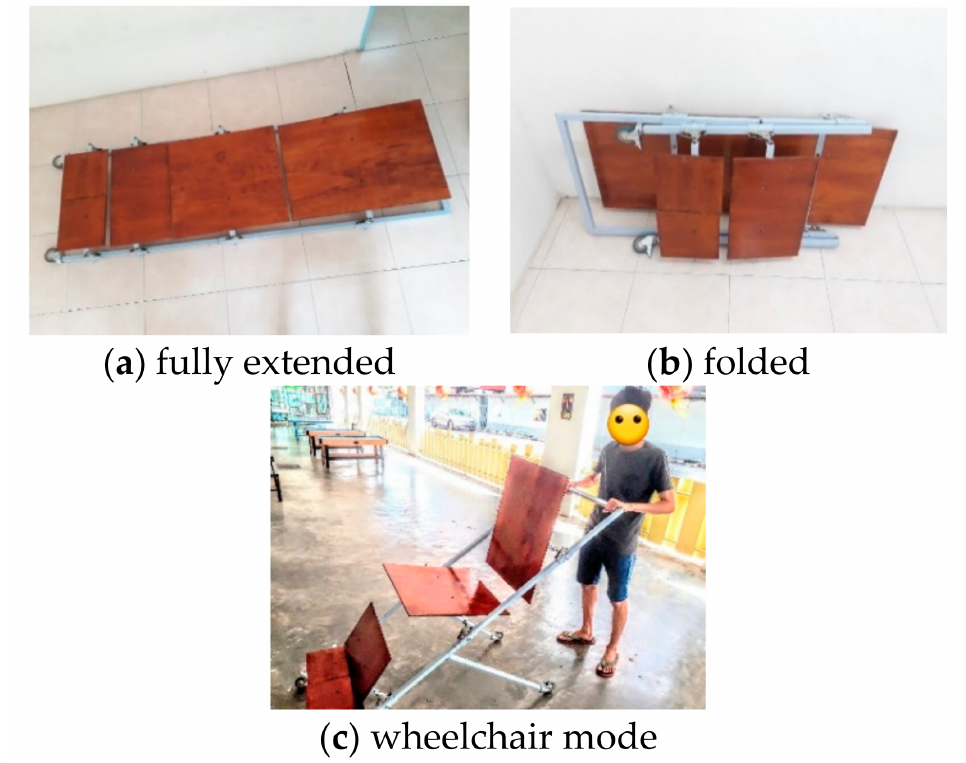
Figure 7. Final product in stretcher, folded and wheelchair